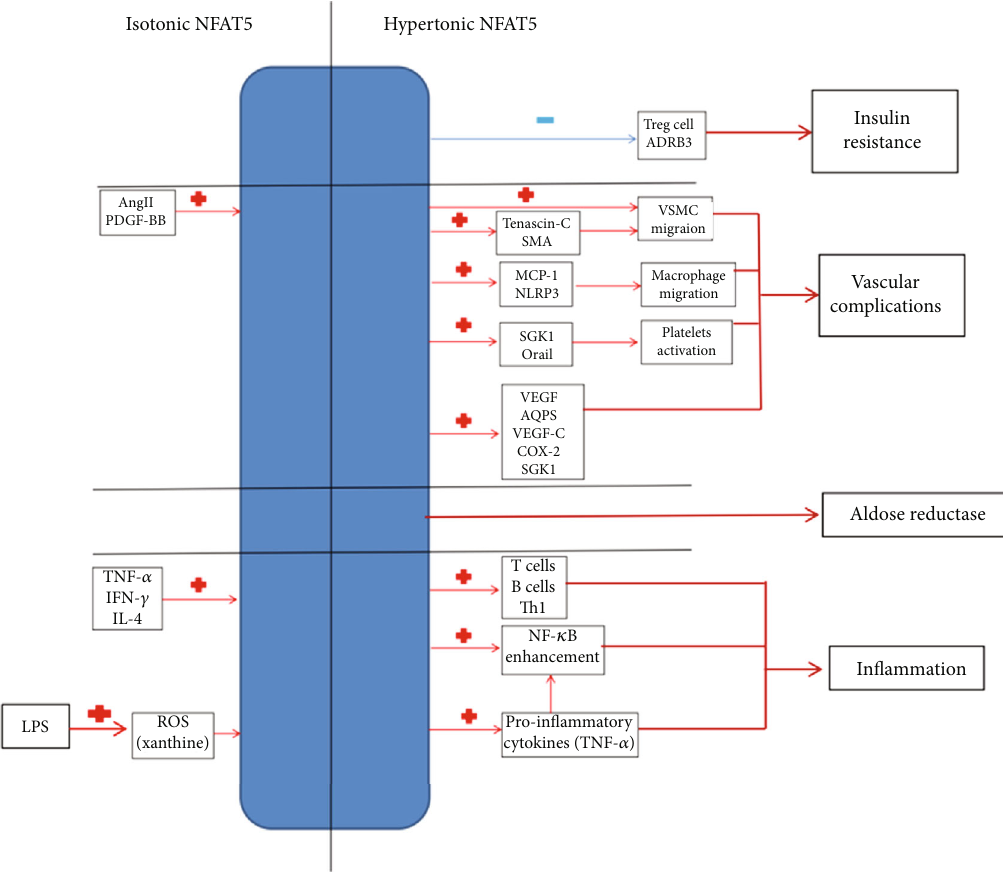
Figure 3: Pathogenic role of NFAT5 in diabetes complications (isotonic/hypertonic NFAT5). β 3-Adrenoreceptor gene (ADRB3), angiotensin- (Ang-) II, aquaporin- (AQP-) 5, cyclooxygenase- (COX-) 2, interferon- (IFN-) γ , interleukin- (IL-) 4, lipopolysaccharide (LPS), monocyte chemoattractant protein- (MCP-) 1, nuclear factor- (NF-) κ B, nucleotide-binding oligomerization domain, leucine-rich repeat, and pyrin domain-containing protein 3 (NLRP3), platelet-derived growth factor- (PDGF-) BB, reactive oxygen species (ROS), regulatory (Treg) T cells, serum- and glucocorticoid-inducible kinase (SGK1), smooth muscle actin (SMA), tumor necrosis factor (TNF)- α , vascular endothelial growth factor (VEGF), and vascular smooth muscle cell